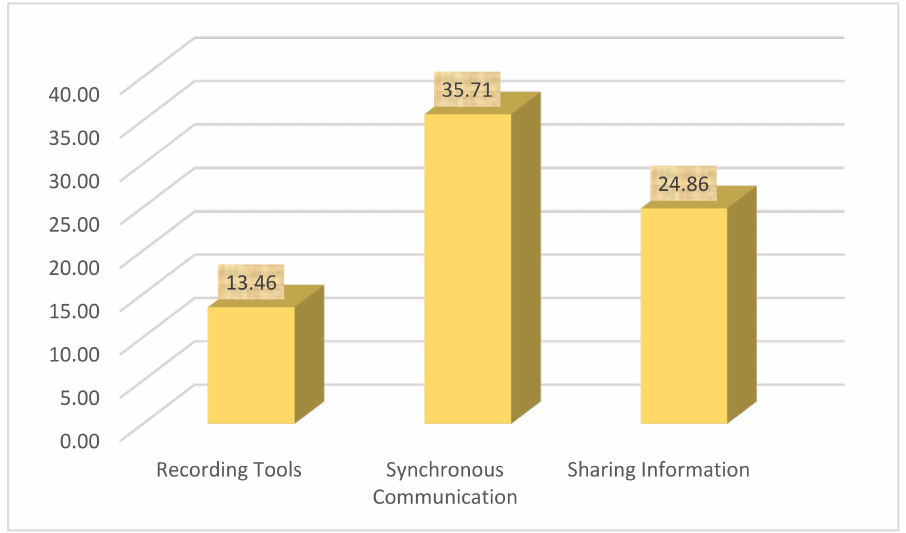
Figure 4. Frequency of use of recording tools, synchronous communications, and sharing